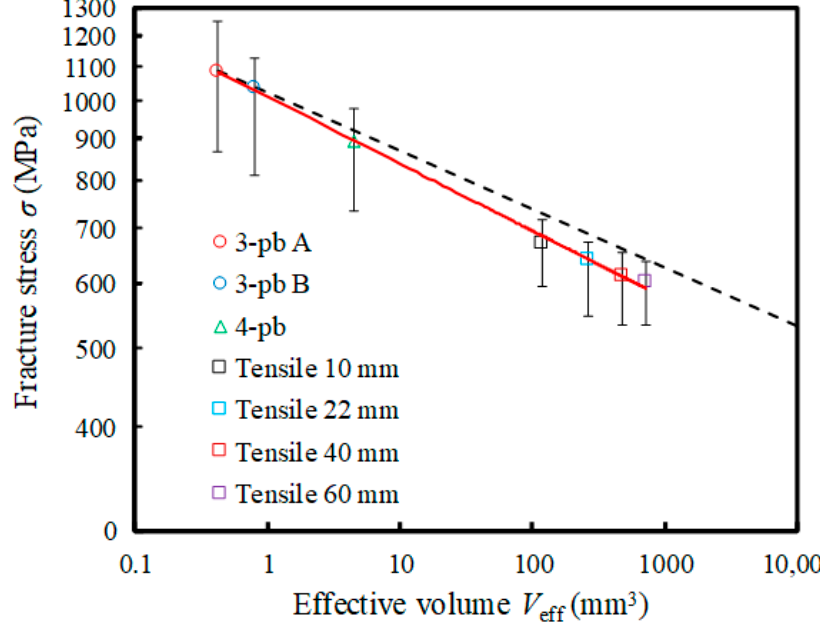
Figure 8. Relationship between the scale parameter β and the effective volume V eff obtained by FEA. The dashed line shows the extrapolation line using the Weibull modulus m 3A of the three-point bending test (Figure 3a).